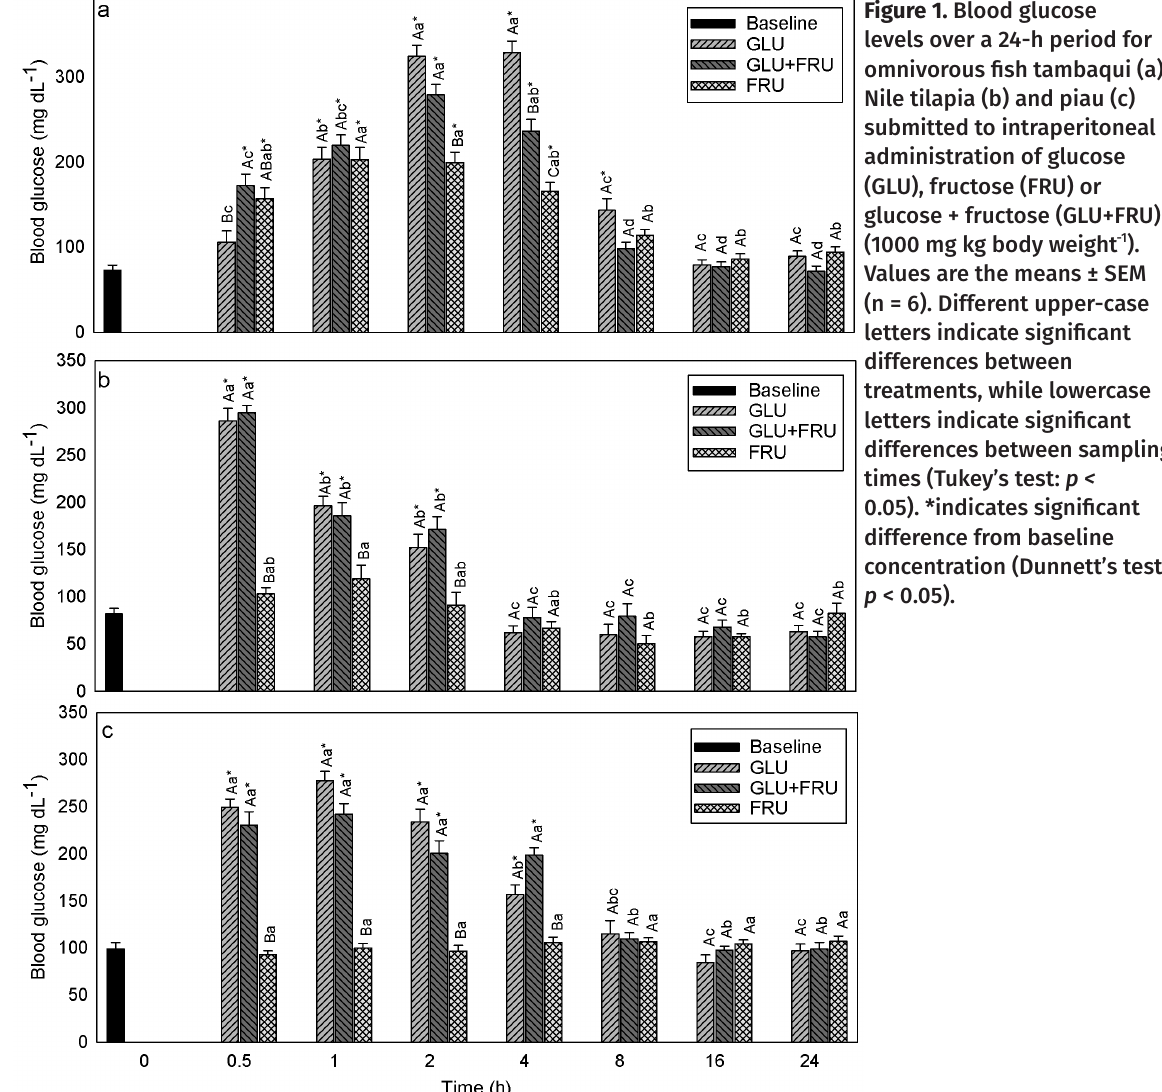
Figure 1. Blood glucose levels over a 24-h period for omnivorous fish tambaqui (a), Nile tilapia (b) and piau